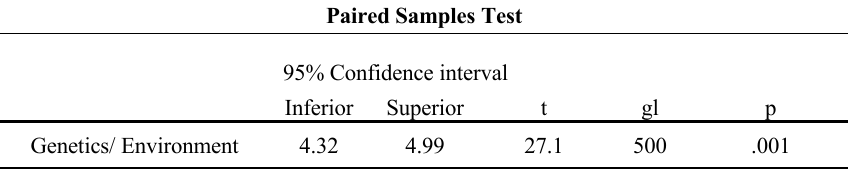
Mean comparison test between the genetics and environmental numerical